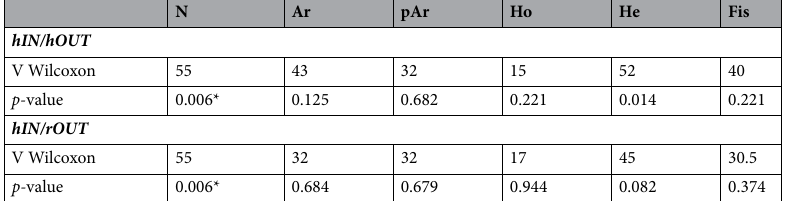
Table 3. Wilcoxon signed-rank test for related samples. hIN/hOUT: Population parameters from the whole dataset (hIN) were compared with those obtained without hybrids (hOUT). To avoid type I errors, the Wilcoxon test was repeated, comparing the results with those obtained after the random removal of individuals (hIN/rOUT). N = population size, Ar = allelic richness, pAr = private allelic richness, Ho = observed heterozygosity, He = expected heterozygosity, Fis = inbreeding index, * = p < 0.008.